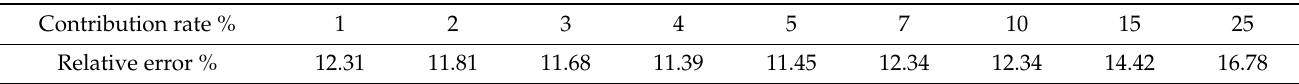
Table 1. The influence of singular value contribution rate on reconstruction